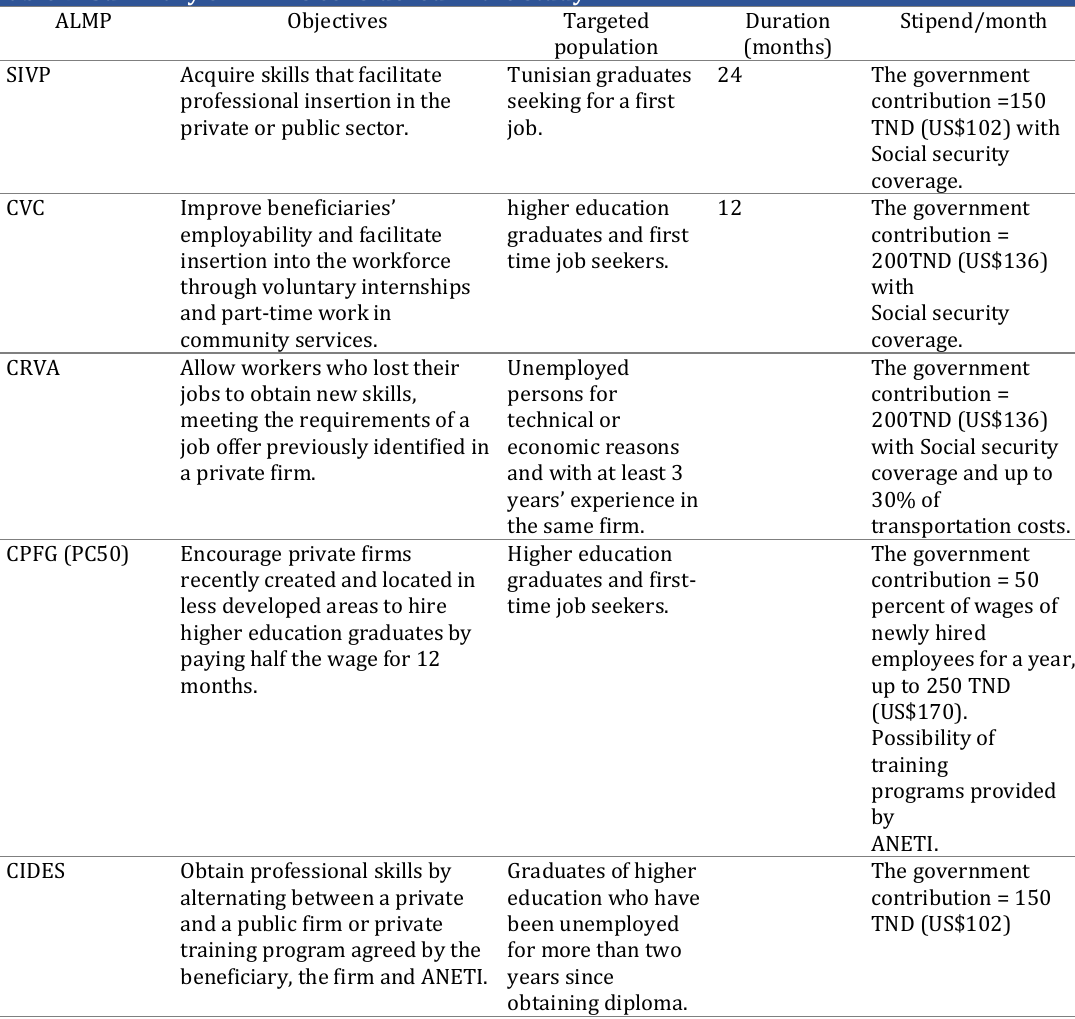
Table 7: Summary of ALMPs considered in the